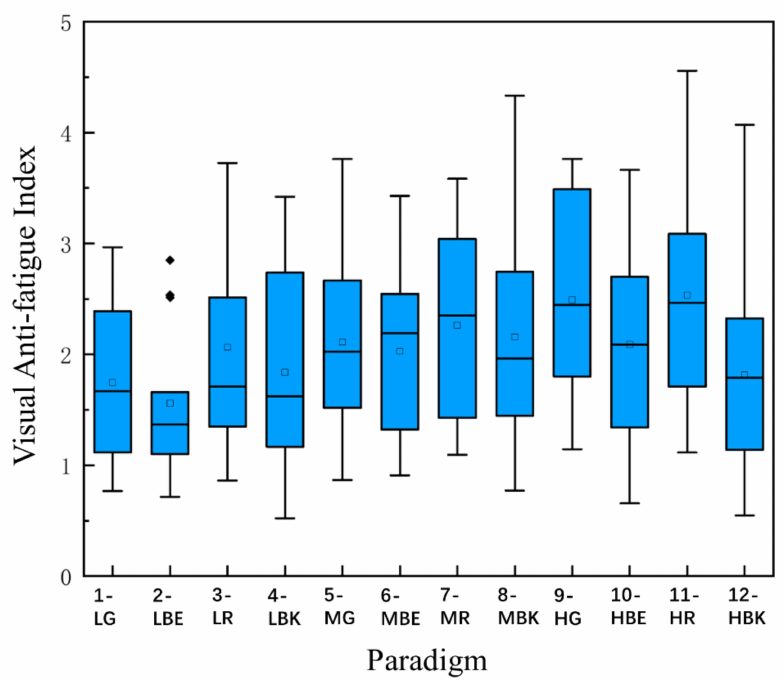
Figure 10. Comparison of the mean values and SD of the visual anti-fatigue index for 12 stimulus paradigms over 15 subjects. Hollow square points represent average values, solid points represent